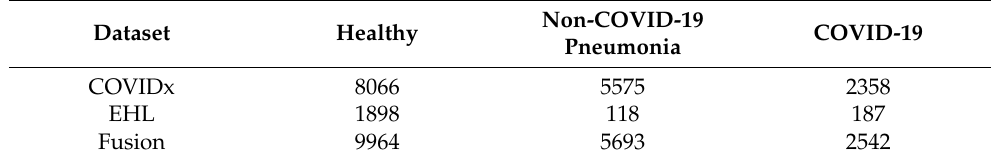
Table 3. Number of images within each